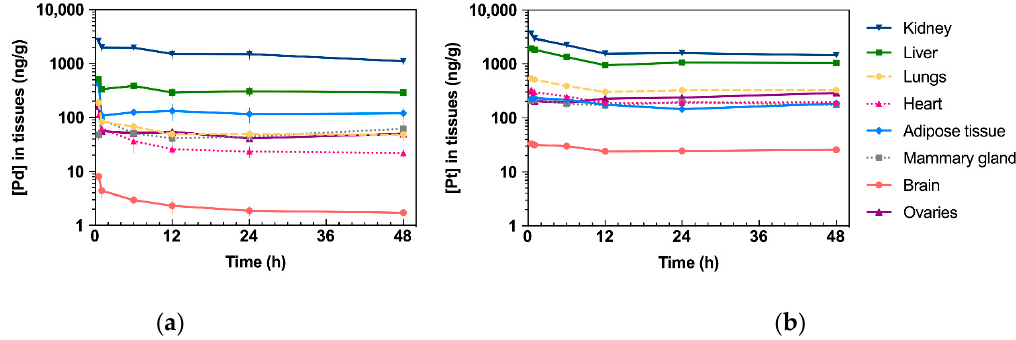
Figure A1. Kinetic profiles of Pd (from Pd2Spm, 3 mg/kg bw) and Pt (from cisplatin, 3.5 mg/kg bw) in tissues after single intraperitoneal bolus injection in Balb/c mice. Data are expressed as mean ± SEM (n = 5 animals per time point). Units: h.ng/g of tissue ( a ) Concentration–time plot of mean Pd levels in tissues. ( b ) Concen-tration–time plot of mean Pt levels in tissues.